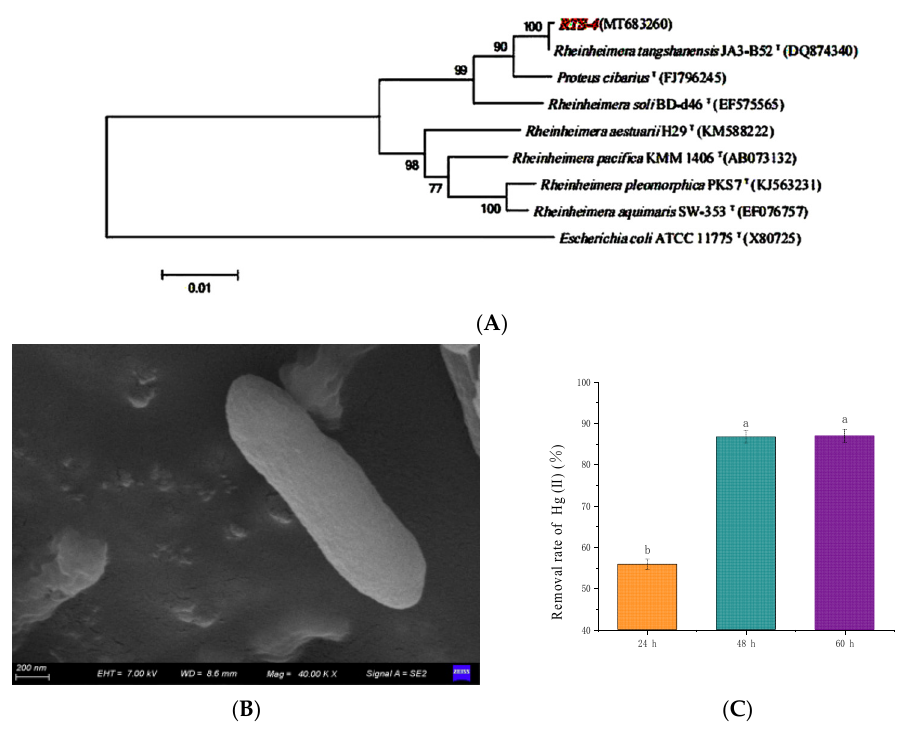
Figure 1. ( A ) Gene sequence phylogenetic tree of the RTS-4 bacteria. Taxonomic classifications were assessed by comparison with the NCBI nucleic acid database. Numbers denote closeness distances between adjacent species. The evolutionary history was inferred using the neighbor-joining method. Escherichia coli ATCC 1175T(X80725) was used as an outgroup. The bootstrap consensus tree inferred from 1000 replicates is taken to represent the evolutionary history of the taxa analyzed. Branches corresponding to partitions reproduced in less than 50% of bootstrap replicates are collapsed. The percentage of replicate trees in which the associated taxa clustered together in the bootstrap test (1000 replicates) are shown next to the branches. The tree is drawn to scale, with branch lengths in the same units as those of the evolutionary distances used to infer the phylogenetic tree. The evolutionary distances were computed using the maximum composite likelihood method, and are in the units of the number of base substitutions per site. The analysis involved 24 nucleotide sequences. Codon positions included were 1st, 2nd, 3rd, and noncoding. All positions containing gaps and missing data were eliminated. There were a total of 1170 positions in the final dataset. Evolutionary analyses were conducted in MEGA5. ( B ) Scanning electron microscopy (SEM) photograph of the RTS-4 bacteria (Voltage, 7.00 kV; magnification, 40.00 KX). ( C ) Hg(II) removal rate of the RTS-4 bacteria in liquid medium at different times. Bars (mean values ± SD) with different letters are significantly different from the three independent experiments at the 0.05 level, according to LSD multiple comparisons.